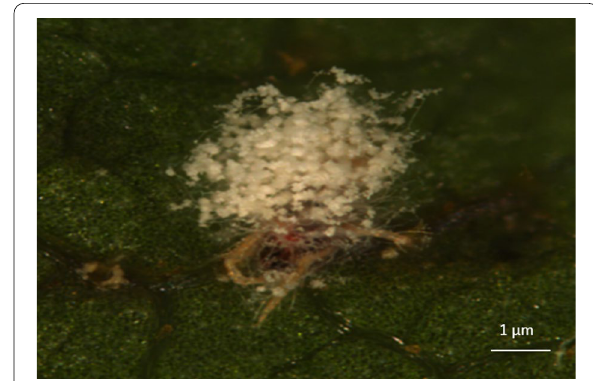
Fig. 1 White cottony growth of entomopathogenic on the dorsal sides of Tetranychus urticae